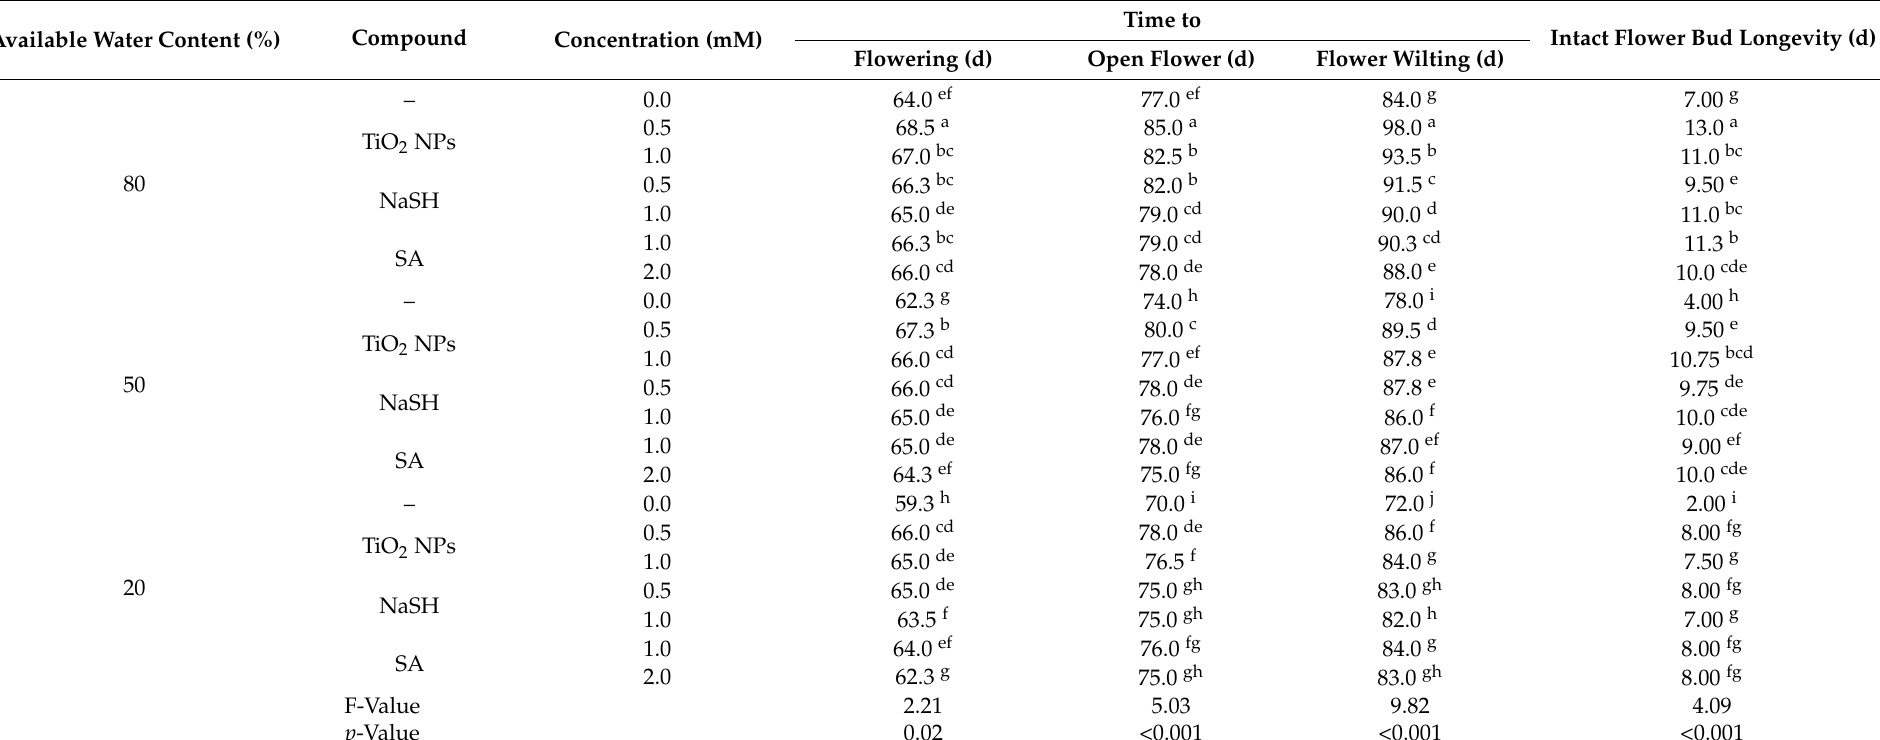
Table 2. Time to flowering (also referred as time to visible bud), time to open flower, time to wilting (i.e., petal turgor loss), and intact (on plant) flower bud longevity [(time to wilting) − (time to open flower)] of periwinkle ‘Pacifica XP Really Red’ plants receiving exogenous application of titanium dioxide nanoparticles (TiO 2 NPs; 0, 0.5 and 1 mM), sodium hydrosulfide (NaSH; 0.5 and 1 mM), or salicylic acid (SA; 1 and 2 mM) under different watering levels (80, 50 and 20% available water content) during cultivation. Means followed by different letters indicate significant differences ( p = 0.05; comparison in columns). Values are the mean of four